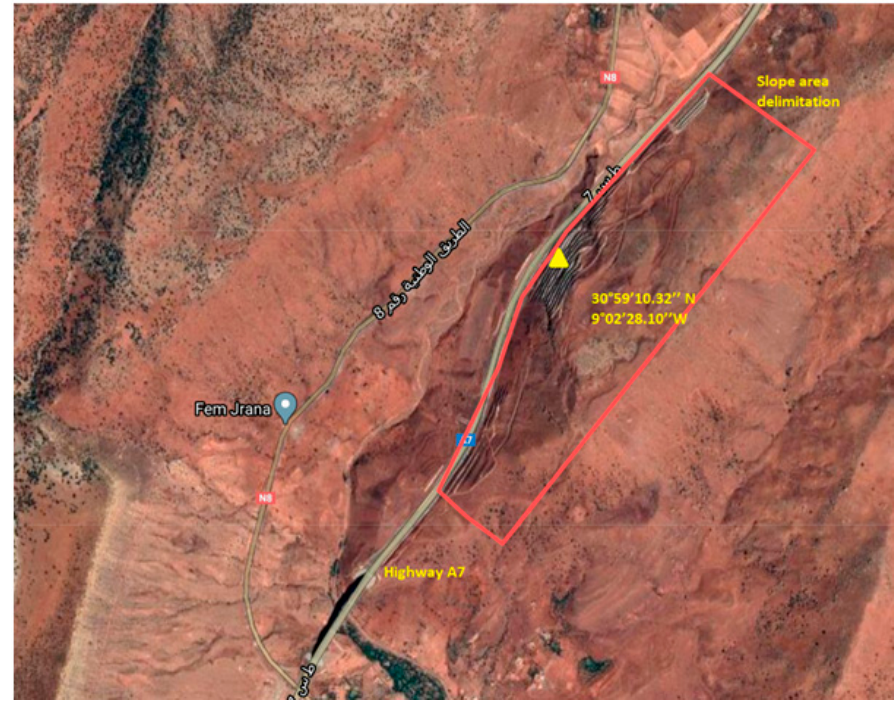
Figure 7. A7 Agadir-Marrakech Moroccan highway geographic area studied. Table 7. Examples of Operations Completed on the A7 Highway Slope. “Operation” Class